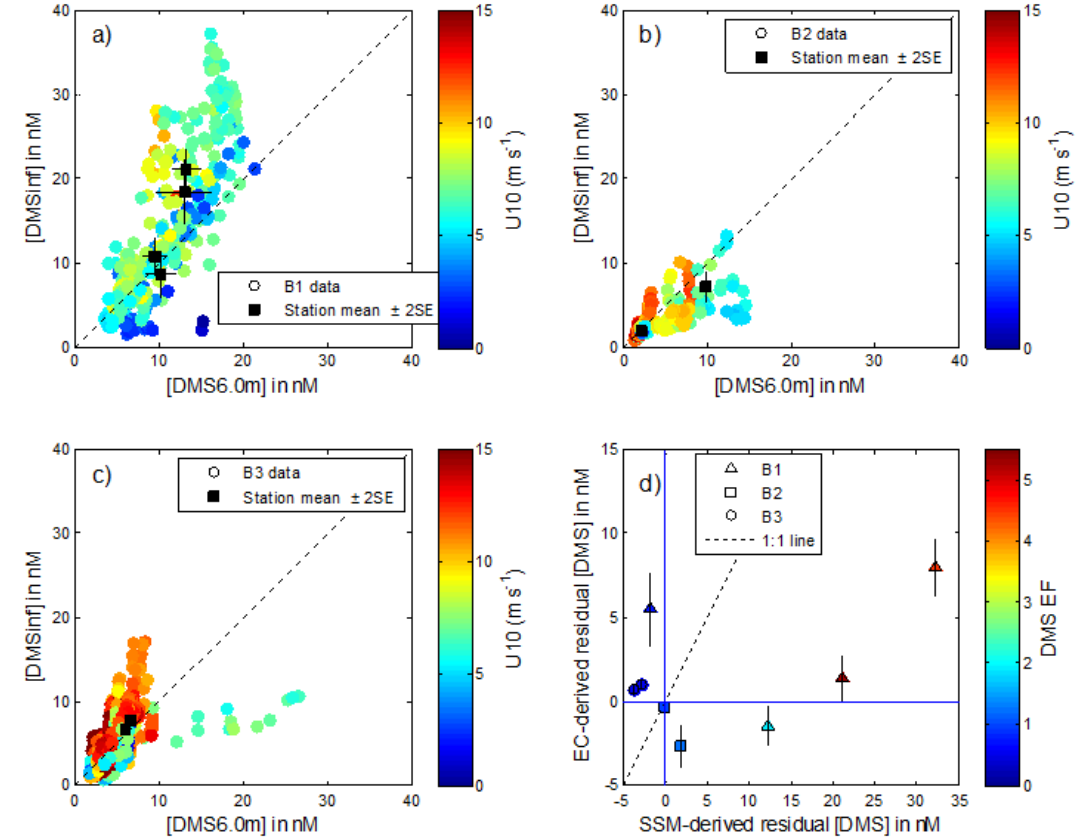
Figure 6. (a–c) Comparison between smoothed [DMS inf ] and [DMS 6 . 0m ] (10min intervals) during each bloom period. The black dashed line indicates the 1 : 1 relationship. The black squares indicate the mean during the period from 3h prior to 5h post-sampling the SSM, with error bars indicating 2 × the standard error. The symbol colour indicates wind speed ( U 10 ) , as shown in the colour bar. (d) Relationship between SSM-derived residual [DMS] and EC-derived residual [DMS] for each SSM station. Data are not available for stations sampled on DOY 47.1, 64.8, and 65.1. Solid vertical and horizontal lines indicate zero residual [DMS] and the dashed line indicates the 1 : 1 relationship. The symbol colour indicates the enrichment factor (EF). The periods used to calculate station means are denoted by shading in Fig.